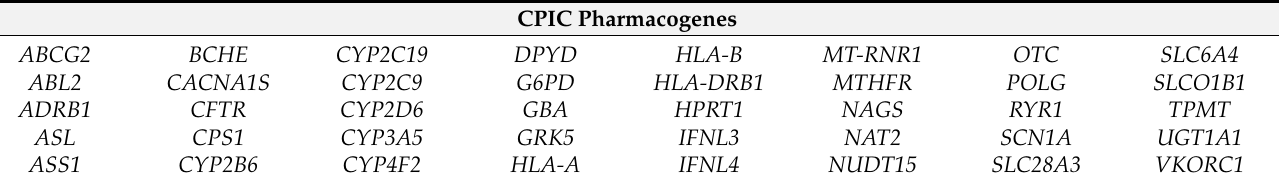
Table A2. CPIC level 1 and level 2